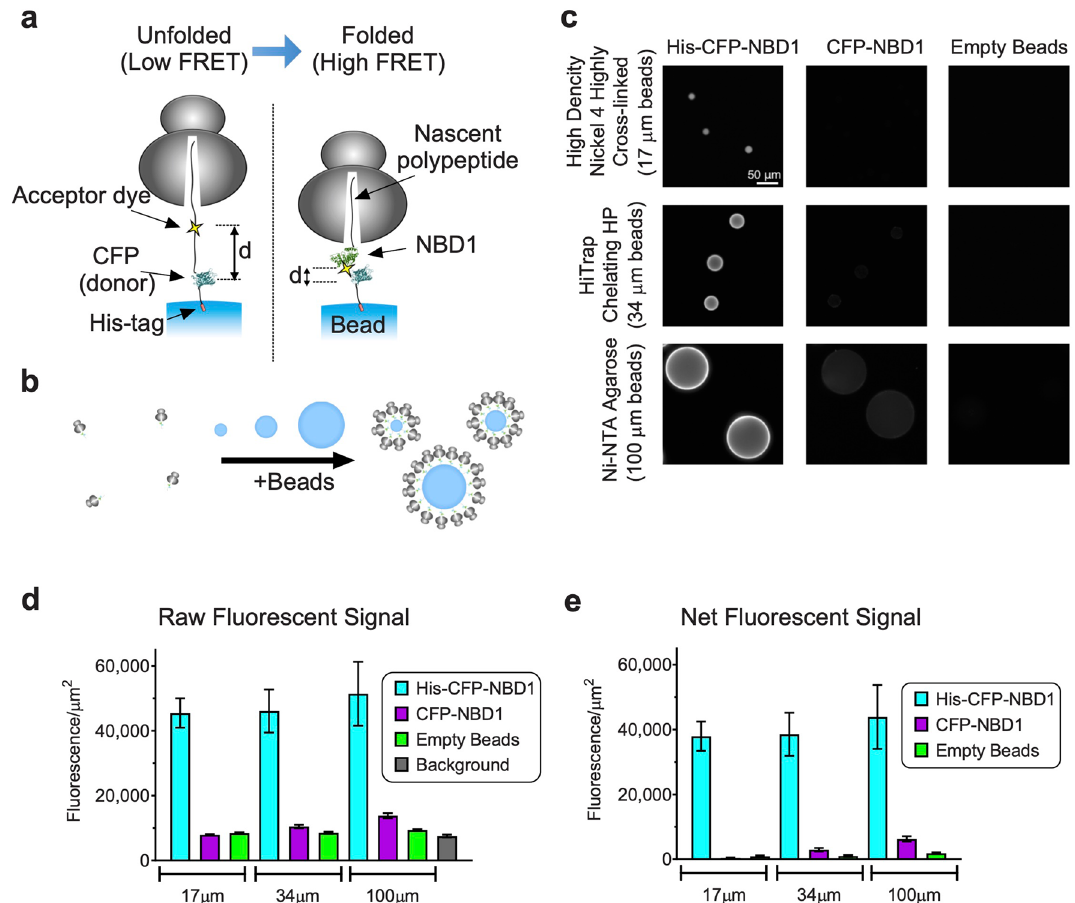
Figure 1. Fluorescent detection of immobilized RNCs. ( a ) Cartoon depicting solid-support FRET assay using translationally incorporated fluorophores to detect structural transitions of ribosome-attached nascent polypeptides immobilized on solid-support surface via His-tag. ( b ) Schematic showing increase in RNC concentration on surface of beads. ( c ) Raw images of beads containing RNC with His 10 -CFP-NBD1. Equivalent amount of RNCs were incubated with 2 × 10 5 of 17 µm beads, 5 × 10 4 of 34 µm beads, and 6 × 10 3 of 100 µm beads as described in “Methods” section. Scale bar, 50 µm. ( d ) Mean fluorescence intensity/µm 2 was obtained from images (mean ± SD, n = 12–99 beads). Mean fluorescence intensities of beads containing His-CFP-NBD1 RNCs and background signal intensity (buffer) were used to calculate signal to background ratios. ( e ) Net fluorescence signal intensity/µm 2 was determined by subtracting background (buffer) (mean ±